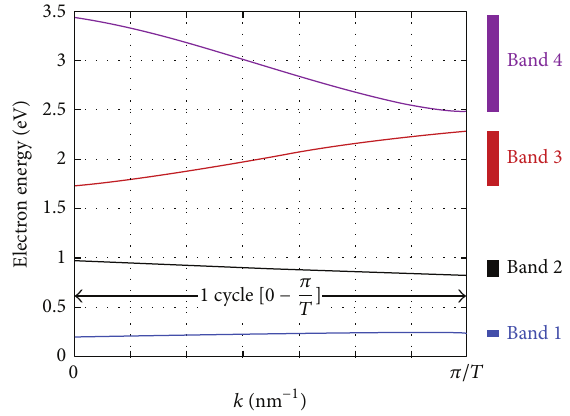
Figure 3: Allowed 𝐸 - 𝑘 states in one-dimensional crystal with the same data in Figure 2.